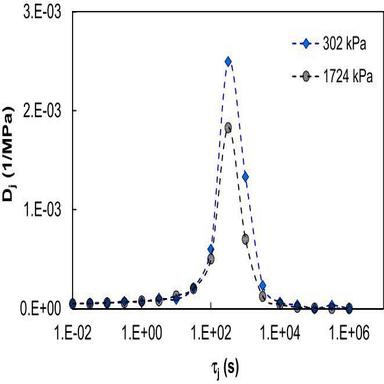
Retardation spectra obtained from numerical conversion.